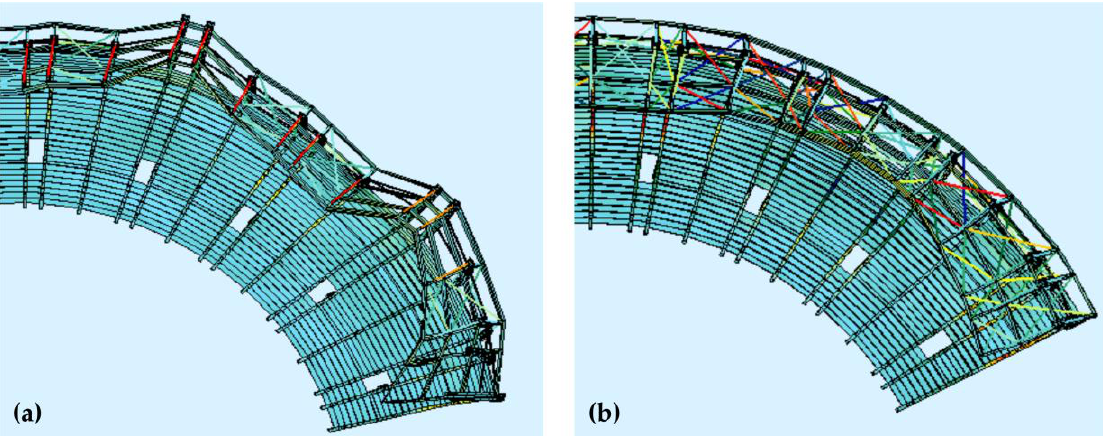
Figure 27. Top view of the stand's roof loaded with synchronous jumps of people showing the vibration amplitudes ( a ) before structural tuning, ( b ) after structural tuning .